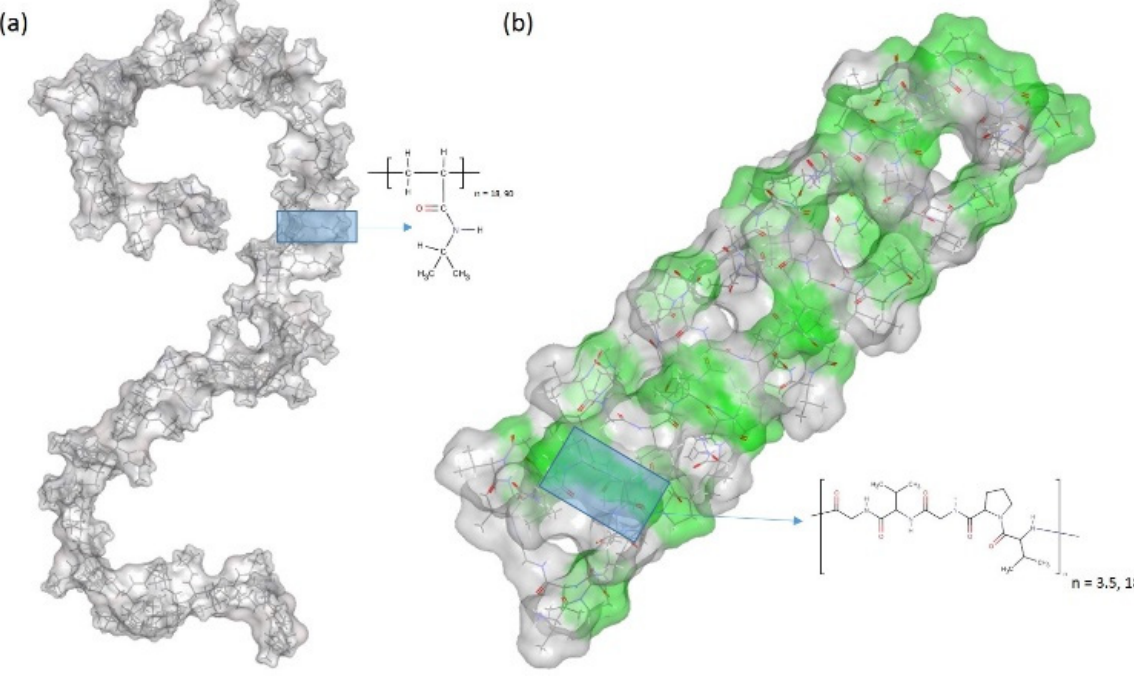
Figure 1. Initial structures of ( a ) a single chain of PNIPAM and ( b ) a β -spiral model of (VPGVG) 18 ELPs, where the β -turns are colored in green and the coils are colored in gray. Details of schematic structures are showed in supporting information. Blue shaded boxes and schematic chemical draw- ings represent the structure of ( a ) PNIPAM monomer and ( b ) VPGVG pentamer.